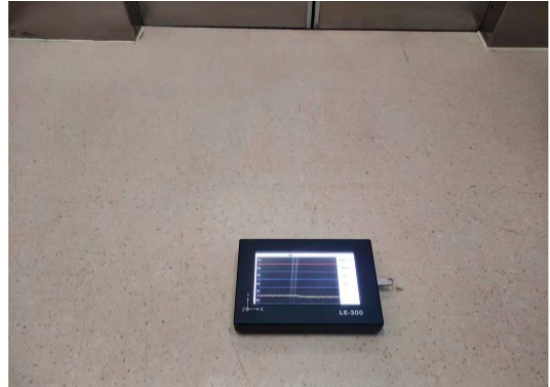
Figure 6. Signal acquisition device.